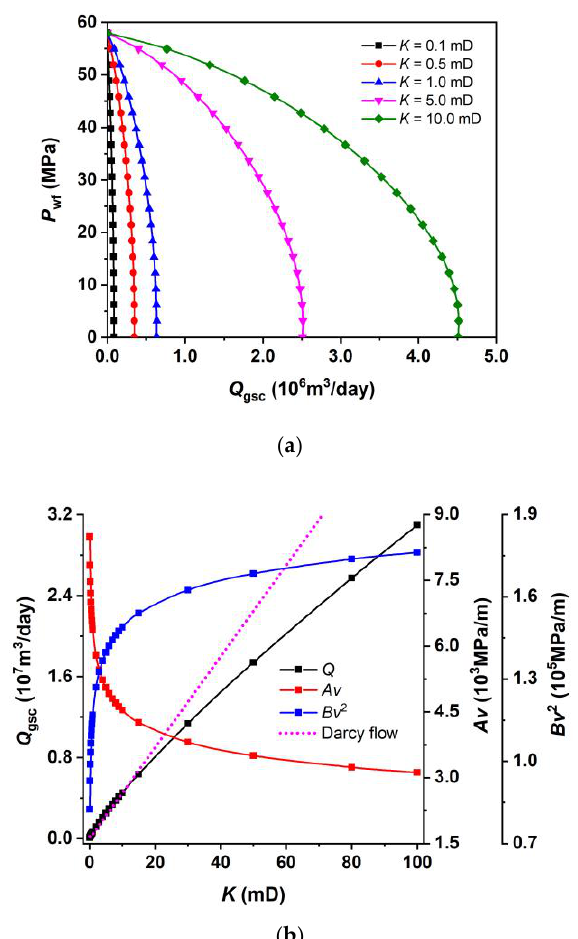
Figure 7. Effect of reservoir permeability on gas production rate and flow characteristics. ( a ) IPR curves with different permeabilities. ( b ) Characteristic analysis of flow regime at the well bottom hole.